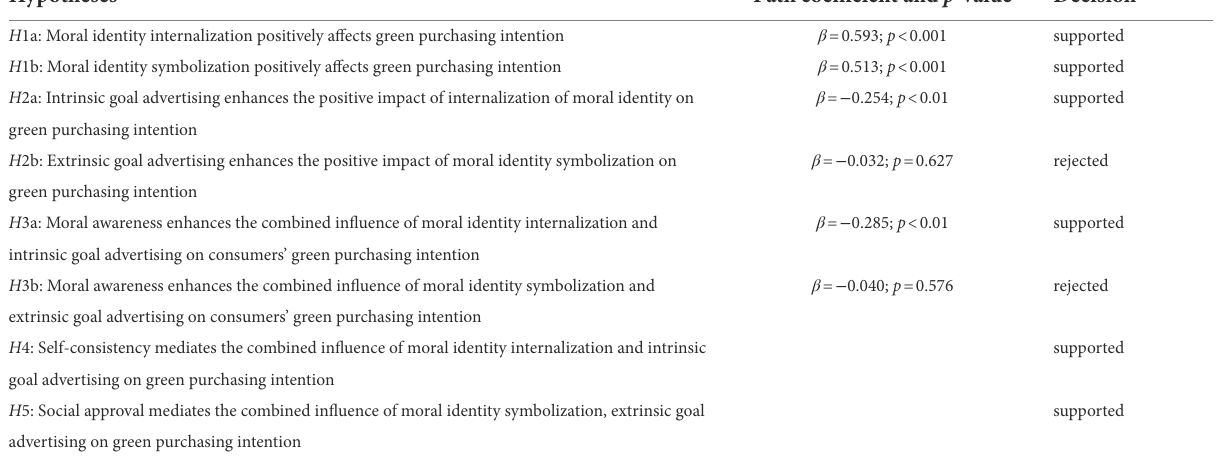
TABLE 5 Results of hypothesis